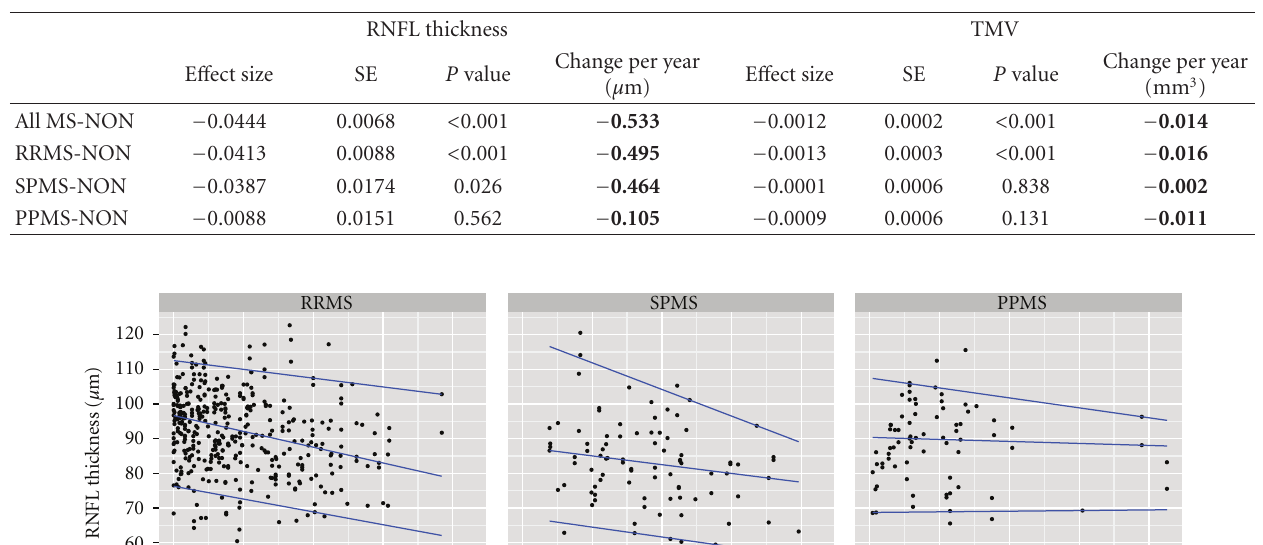
Table 5: Generalized estimation equation (GEE) models correlating disease duration with RNFL thickness and TMV, respectively. The yearly change based on the e ff ect sizes of the respective GEE model.